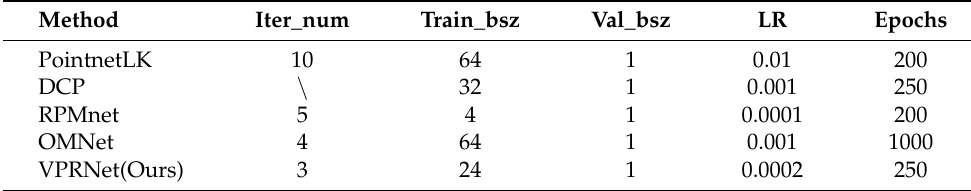
Table 1. Important training and testing parameters used in deep learning methods. \ means that there is no such parameter in the algorithm. Iter_num represents the number of iterations, Train_bsz and Val_bsz represent the batch size during training and testing, LR represents the learning rate, and Epochs represents the number of times all the training data is